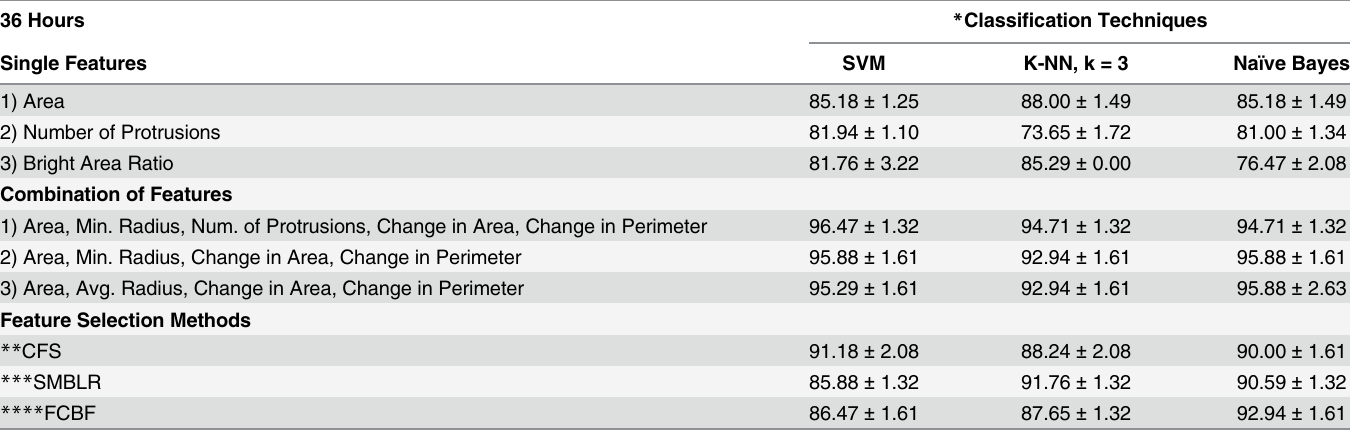
Table 2. Classification Results Using 36 Hours of